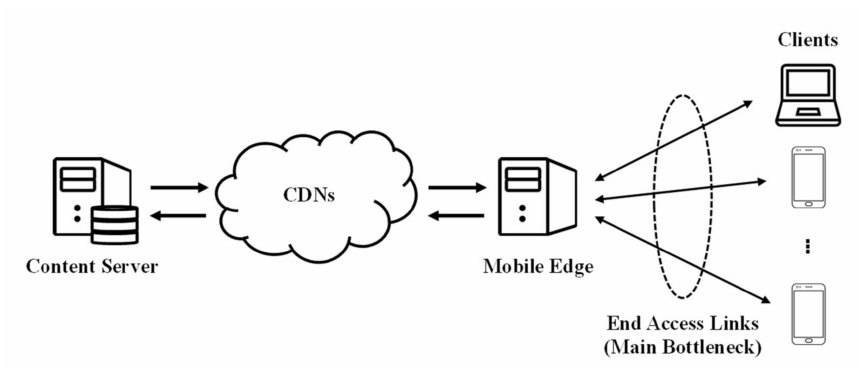
Figure 6. Networking model for multi-client adaptive streaming in edge computing